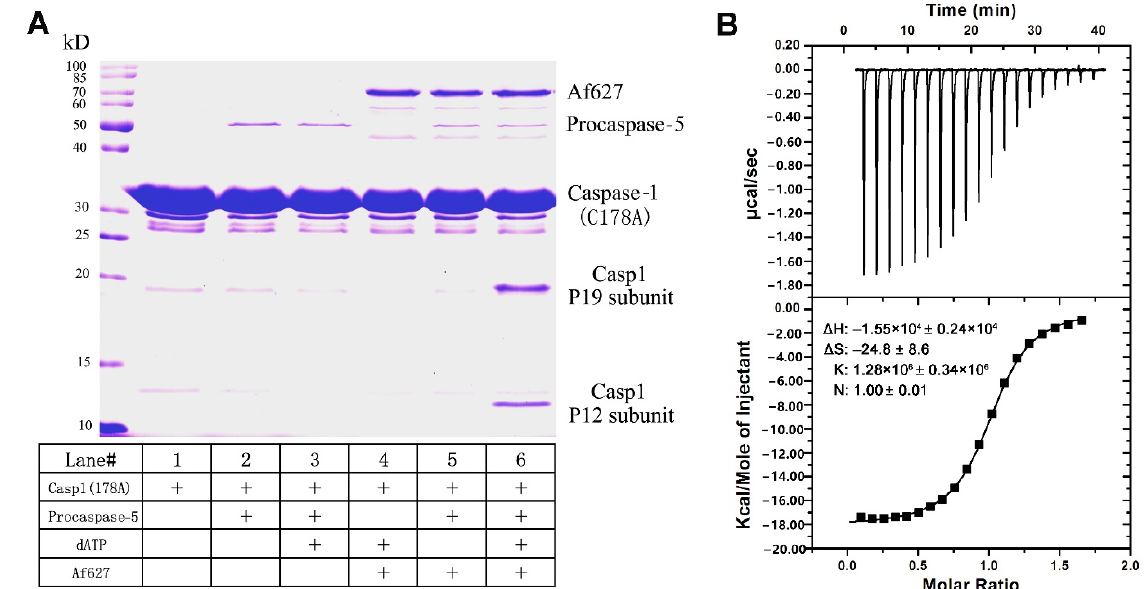
Figure 5. Sl-Apaf-1 triggers Sl-caspase-5 activation in vitro according to the ITC assay. ( A ) Sl-Apaf-1, Sl-caspase-5, and Sl-caspase-1 (Casp1) were expressed and purified. These proteins were incubated under different treatments and then separated by SDS-PAGE analysis. Activity was assayed by cleavage of Sl-caspase-1. Sl-caspase-1 is shown in lane 1. Sl-procaspase-5 could not directly activate the Sl-caspase-1 (lines 2 and 3). Sl-Apaf-1 could not directly trigger Sl-caspase-1 activation in the absence of ATP and procaspase-5 (lanes 4 and 5). Only in the presence of both procaspase-5 and dATP, could Sl-Apaf-1 activate Sl-caspase-1, which lead to the processing of Sl-caspase-1 to generate the p19 large subunit and the p12 small subunit (see lane 6). ( B ) ITC assay of the interaction between the Sl-Apaf-1-CARD domain protein fragment and the Sl-caspase-5-CARD domain protein fragment. Upper panel, interaction of the Sl-Apaf-1-CARD domain with the Sl-caspase-5-CARD domain. Lower panel, control: Reaction buffer interaction with caspase-5-CARD domain. Upper panel—raw ITC data, lower panel—integrated ITC data with the curve.